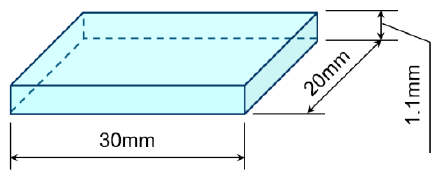
Figure 1. Size of glass specimen.